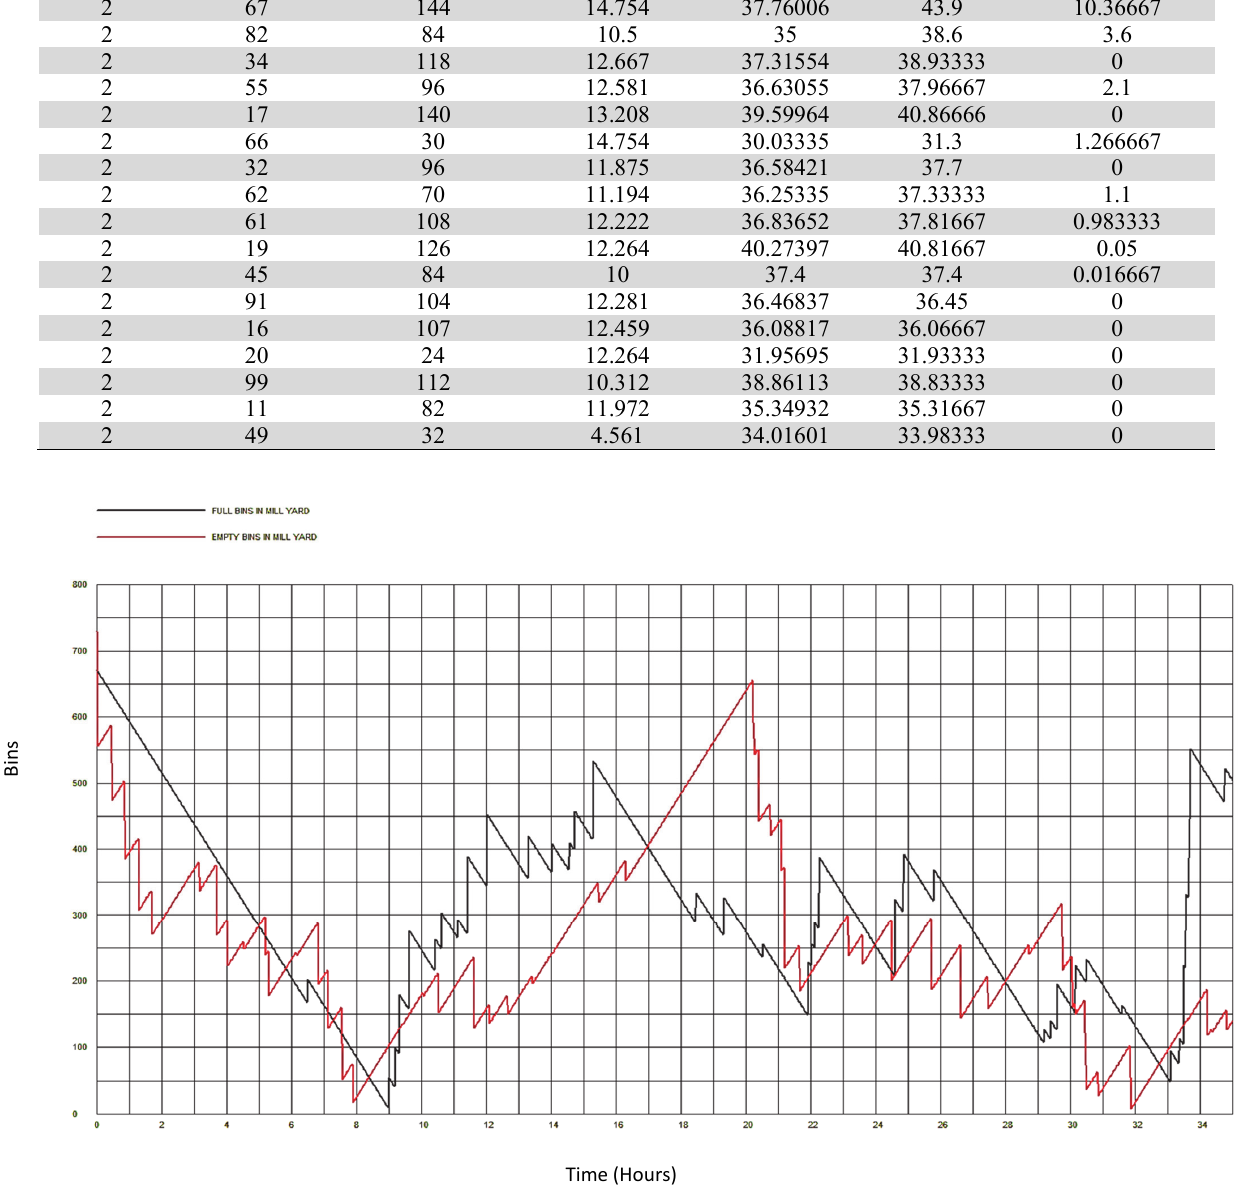
Fig. 9 . Empty and full bins at Mill in the second